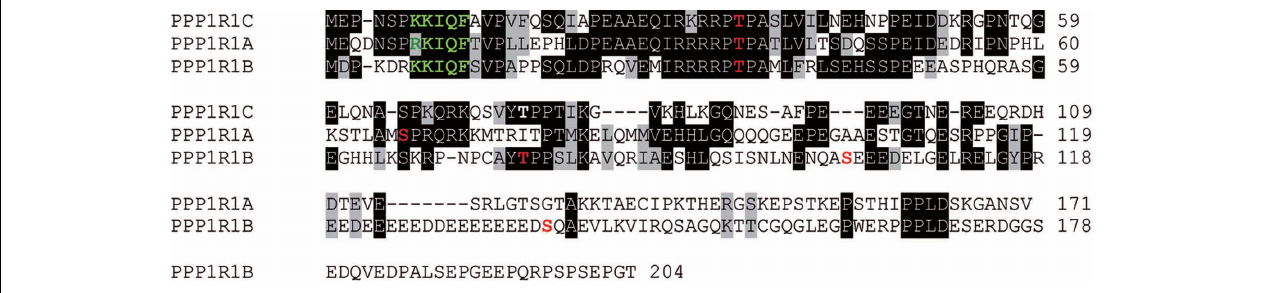
FIGURE 1 | Multiple sequence alignment of human PPP1R1 family members. Human amino acid sequences of PPP1R1C (IPP-5, gi|17389867|gb|AAH17943.1|), PPP1R1A (I-1, gi|48146123|emb|CAG33284.1|), and PPP1R1B (DARPP-32, gi|119580986|gb|EAW60582.1|) were obtained from NCBI data base and aligned by Clustalview. Identical residues are shaded black and similar ones gray.The known phosphorylation sites are in red and the PP1 binding motif in green.